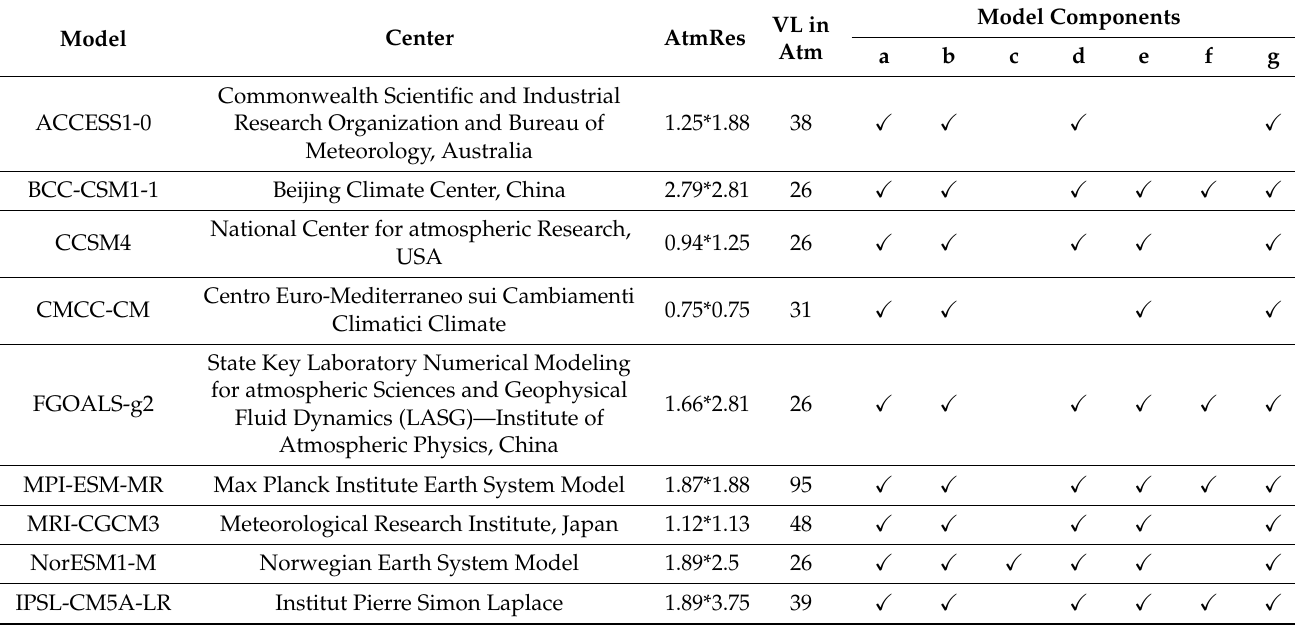
Table 1. GCM data properties used in this